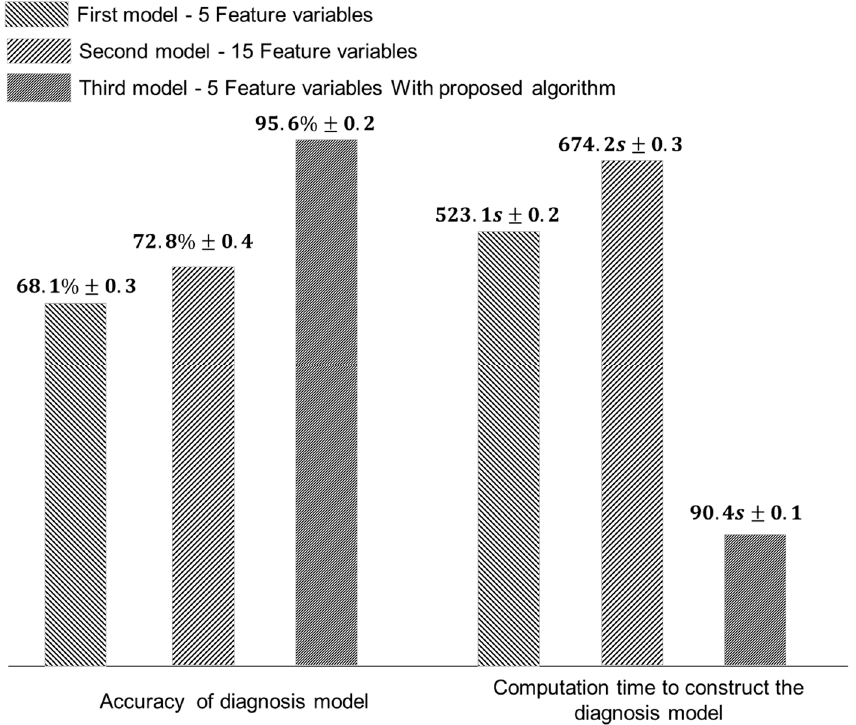
Figure 10. Accuracy and computation time of diagnosis models for SM45C.